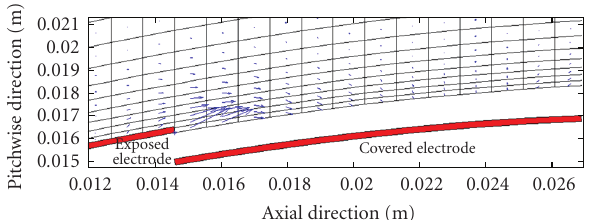
Figure 6: Mapping of the actuator’s force distribution onto a blade suction surface mesh.